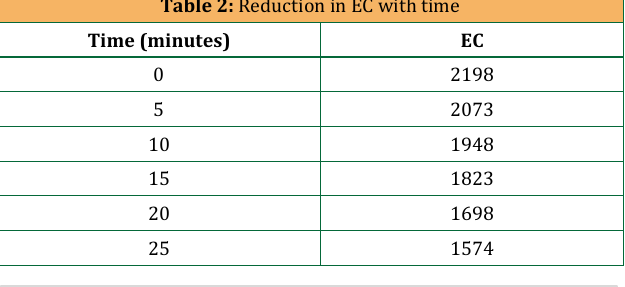
Table 2: Reduction in EC with time